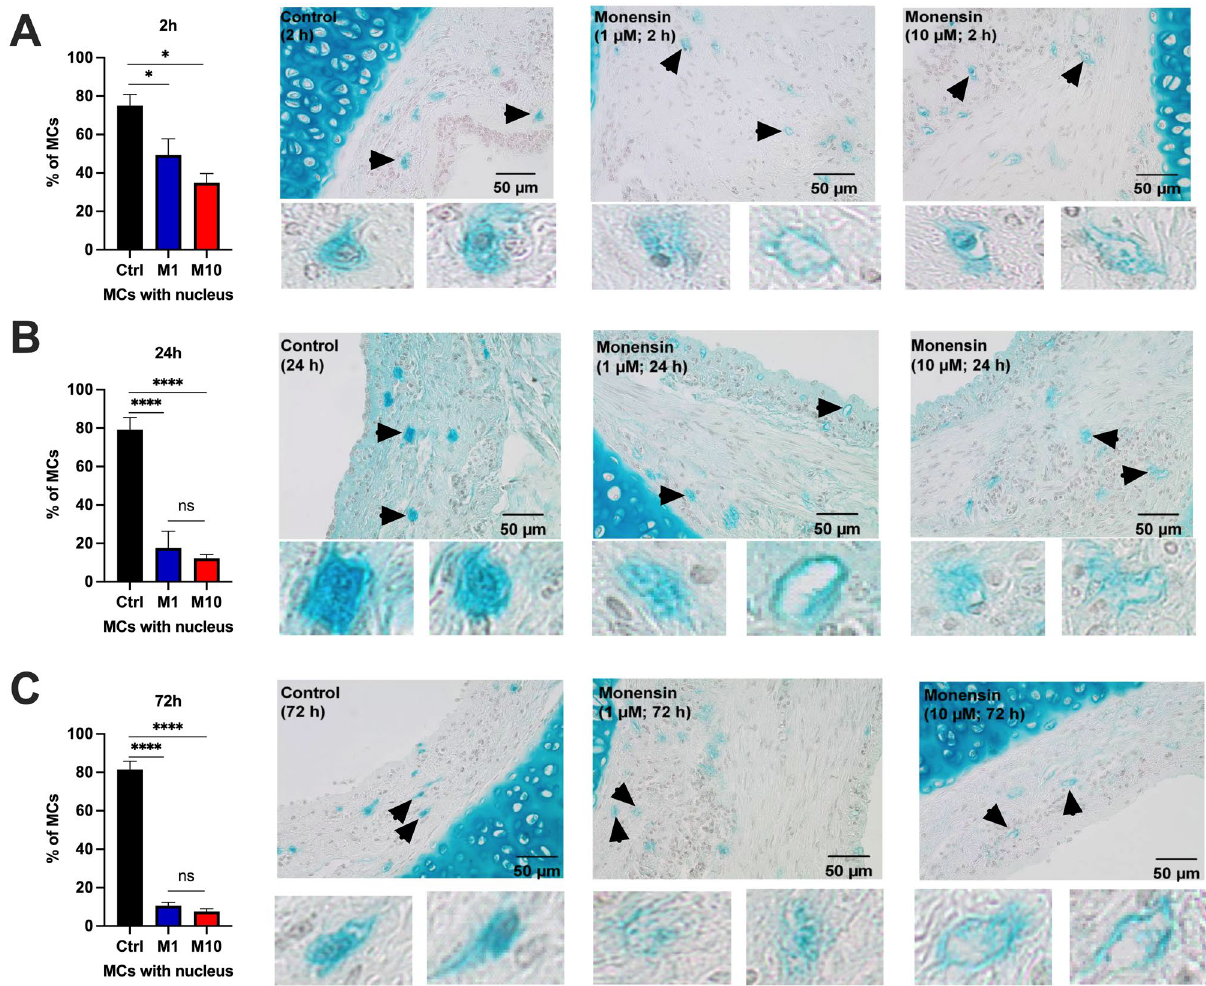
Figure 2. Astra blue-Hematoxylin staining of guinea pig trachea after 2 to 72 h exposure to monensin. Percentage of mast cells that have detectable nuclei after ( A ) 2 h, ( B ) 24 h and ( C )72 h exposure to 1 µM (M1) or 10 µM (M10) monensin, or vehicle (1% ethanol; Ctrl) with representative pictures on the right (n = 3–8 per group). Arrows denote the magnified mast cells. * p < 0.05 and **** p <